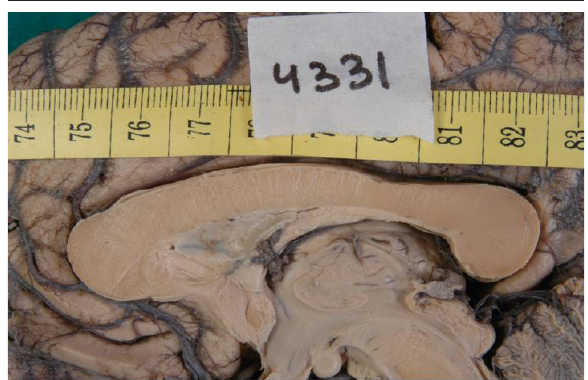
figure 1. Mid-sagittal section of brain showing corpus callosum.